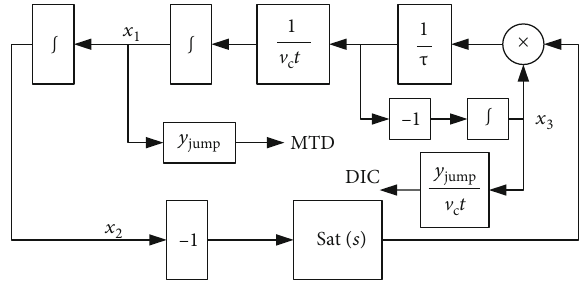
Figure 9: Adjoint block diagram of the numeric derivative model.